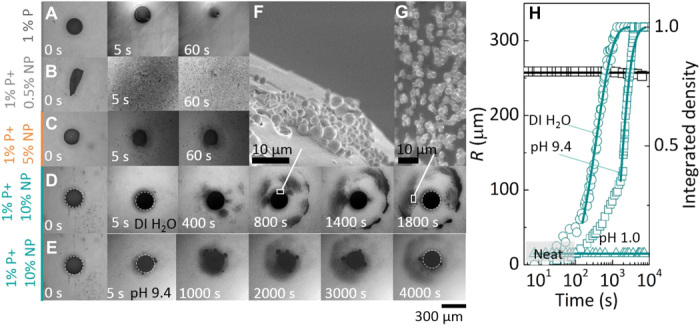
Dissolution of NaPSS/silica composite capsules.Optical images of dissolution of capsules of (A) 1% (w/v) NaPSS, (B) 1% (w/v) NaPSS + 0.5% (w/v) silica, (C) 1% (w/v) NaPSS + 5% (w/v) silica, and (D) 1% (w/v) NaPSS + 10% (w/v) SiO2 at pH 5 and (E) pH 9.4. The final capsule radius was ≃250 μm in all cases. (F) High-magnification images of the surface cracks of the capsule and (G) the emanating micrometer-sized nanoparticle clusters. (H) The droplet radius of the composite 1% (w/v) NaPSS/10% (w/v) SiO2 capsule was found to remain approximately constant over time, and the release of micrometer-sized nanoparticle clusters occurs in bursts, over long time scales, tunable with pH. Lines shown are fits of the well-known Weibull empirical model [I = 1 − exp(−a(t − ti))b, where I is the integrated intensity in our case; a and b are the scale and shape parameters, respectively; t is time; and ti is the induction time] to the experimental data. DI, deionized.